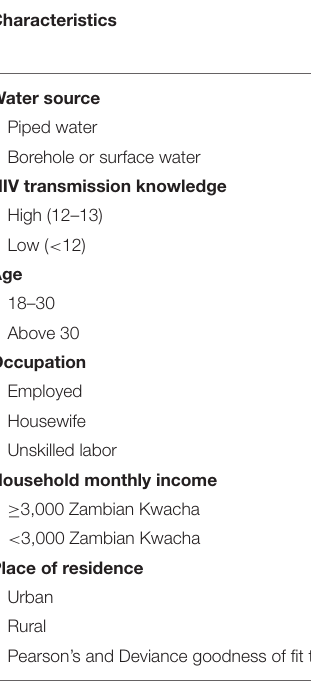
TABLE 2 | Regression models for predictors of ART adherence intention ( N =